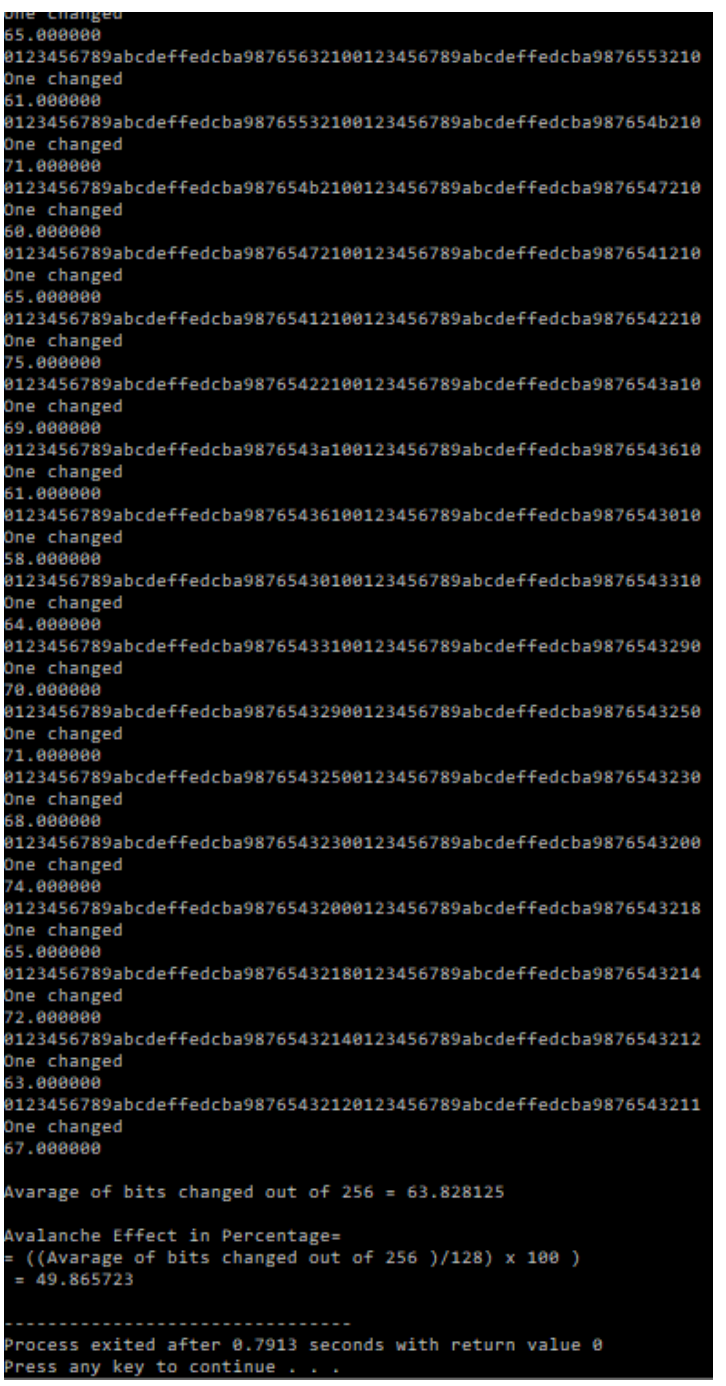
Figure 9. Experimental Avalanche Effect of Serpent when one bit of a key was